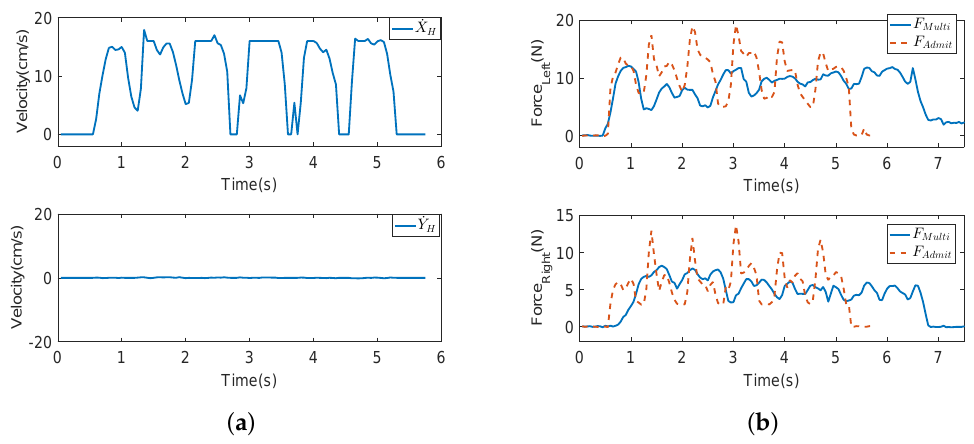
Figure 9. The results of Compliance Control Experiment I. In this experiment, the user goes straight with the robot. ( a ) The velocities in the X-axis. ( b ) The velocities in the Y-axis.